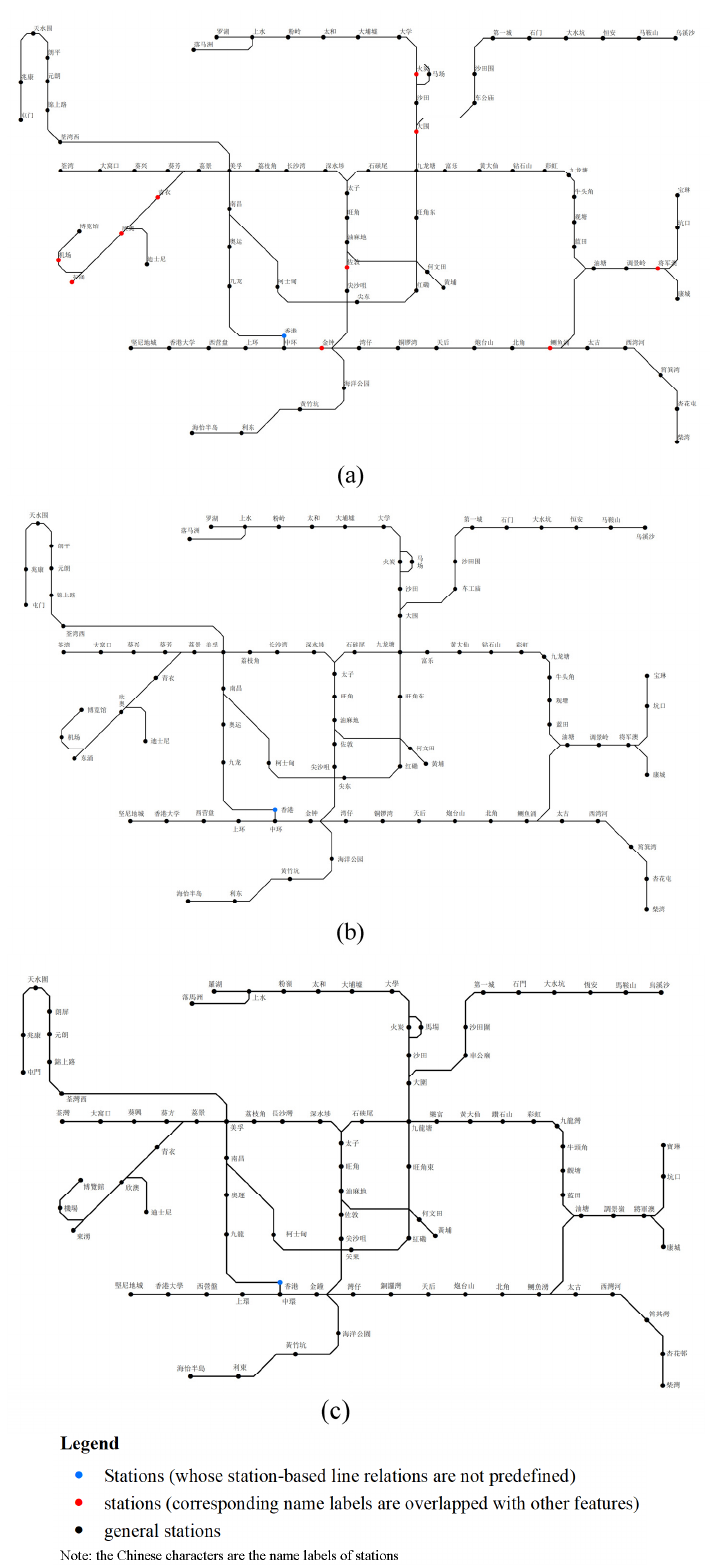
Figure 12. Name labels of Tianjin metro networks placed by: ( a ) maplex; ( b ) descriptive-statistics- based method; and ( c ) ANNs.